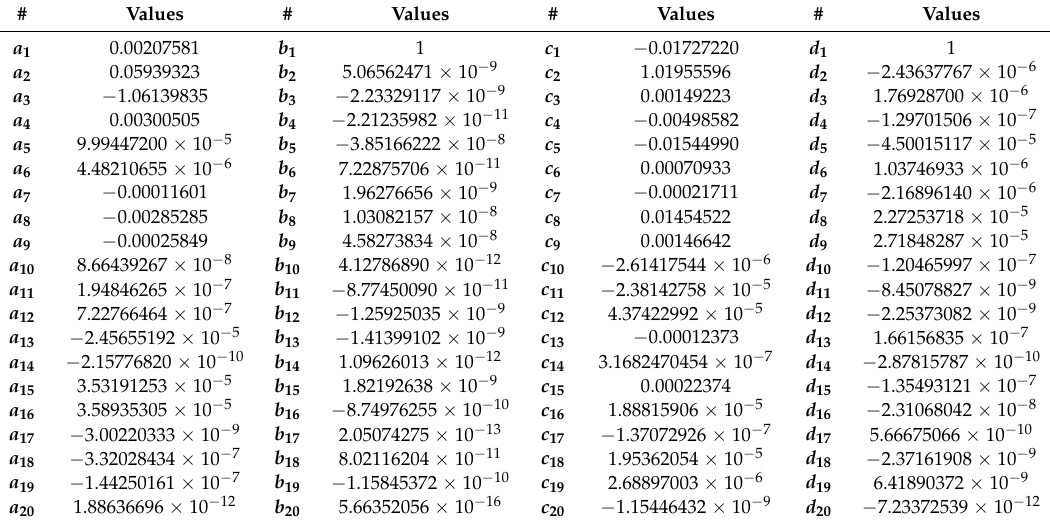
Table 4. Rational function polynomial coefficients of the second study area.